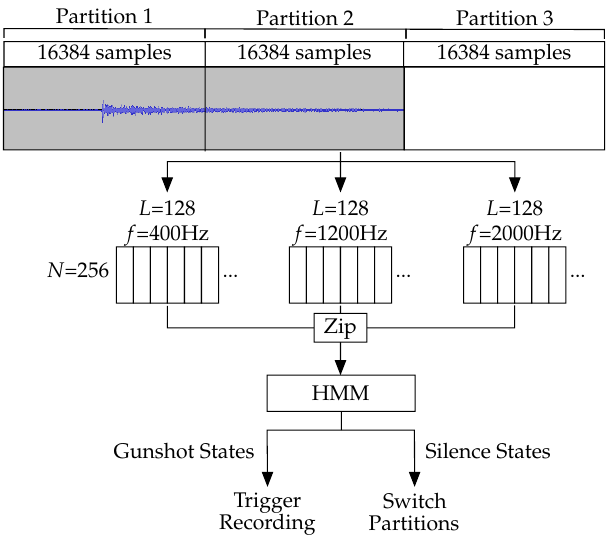
Figure 11. Overview of the data collection and gunshot detection process. Samples are collected and stored in three partitions in SRAM. Once two have been filled, the detection algorithm is run while the third fills. Once the third has been filled, the algorithm is run again on the most recent two partitions. If a gunshot does not fit into a single partition, each partition is used twice meaning the full gunshot will be in the next